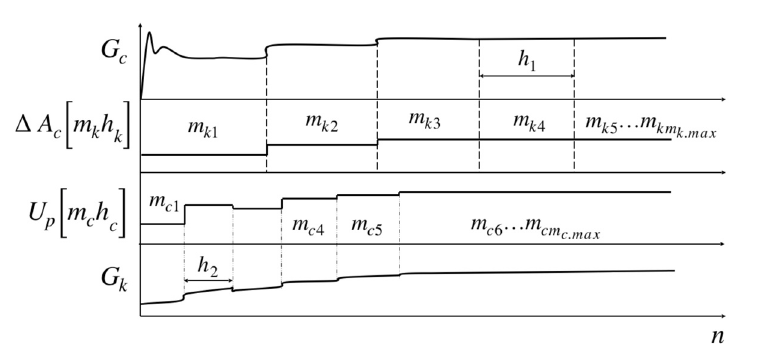
Figure 5. Function of the converter ( G c ) and kinematic ( G k ) dynamics correction at the ends of the structure intervals [1].